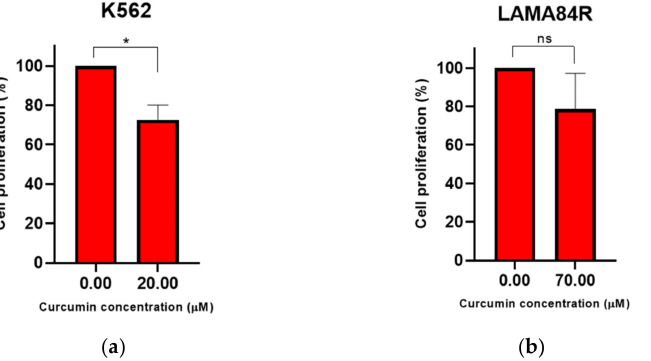
Figure 4. Curcumin effects on K562 ( a ) and LAMA84R ( b ) cell proliferation rates evaluated through BrdU incorporation assay after 48 h of curcumin treatment. The mean ± standard deviations are shown. ns – not significant, * p < 0.05.